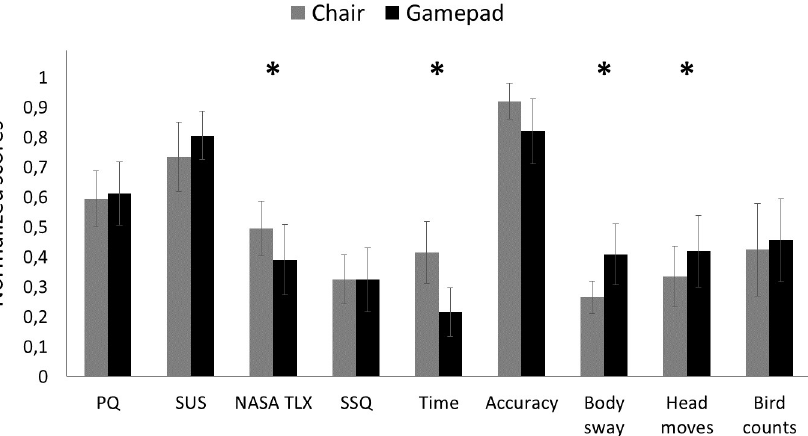
Fig 9. Bar chart of all dependent measures from Experiment 2. For this visualization only, each dependent measure was normalized to a value between 0 and 1 by subtracting the minimum value from each individual value and then dividing by the maximum value. Error bars represent ± 2 SEMs. Asterisks denote a significant main effect of control interface. Larger values are desirable for the presence questionnaire (PQ), system usability scale (SUS), Accuracy, and Bird counts. Smaller values are desirable for workload (NASA TLX), simulator sickness questionnaire (SSQ), Time, and Body sway.